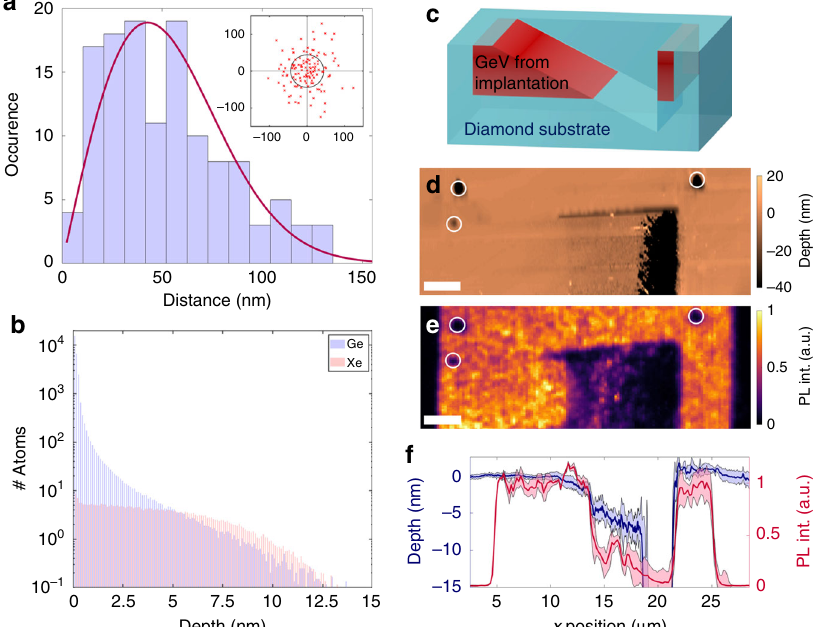
Fig. 3 Spatial distribution of the dopants. a Distribution of the ensemble position (GeV) relative to the nominal implantation site, fi tted by a Rayleigh function with a mode of (44 ± 4) nm. The inset shows directly the relative ensemble position. b Monte Carlo simulations of the depth distribution of Ge in diamond from a Xe + recoil-implantation process and of the co-implanted Xe. c Schematic of the wedge edge to access the implantation pro fi le of an area with the implanted species. d AFM map of the wedge prepared by EBIE. e PL map of the same Ge-implanted area. The positions of both maps were correlated by the three marked spots. Scale bars in d , e correspond to 2.5 μ m. f Average pro fi le of depth (blue) and PL (red) along the wedge feature. The shaded areas represent the standard